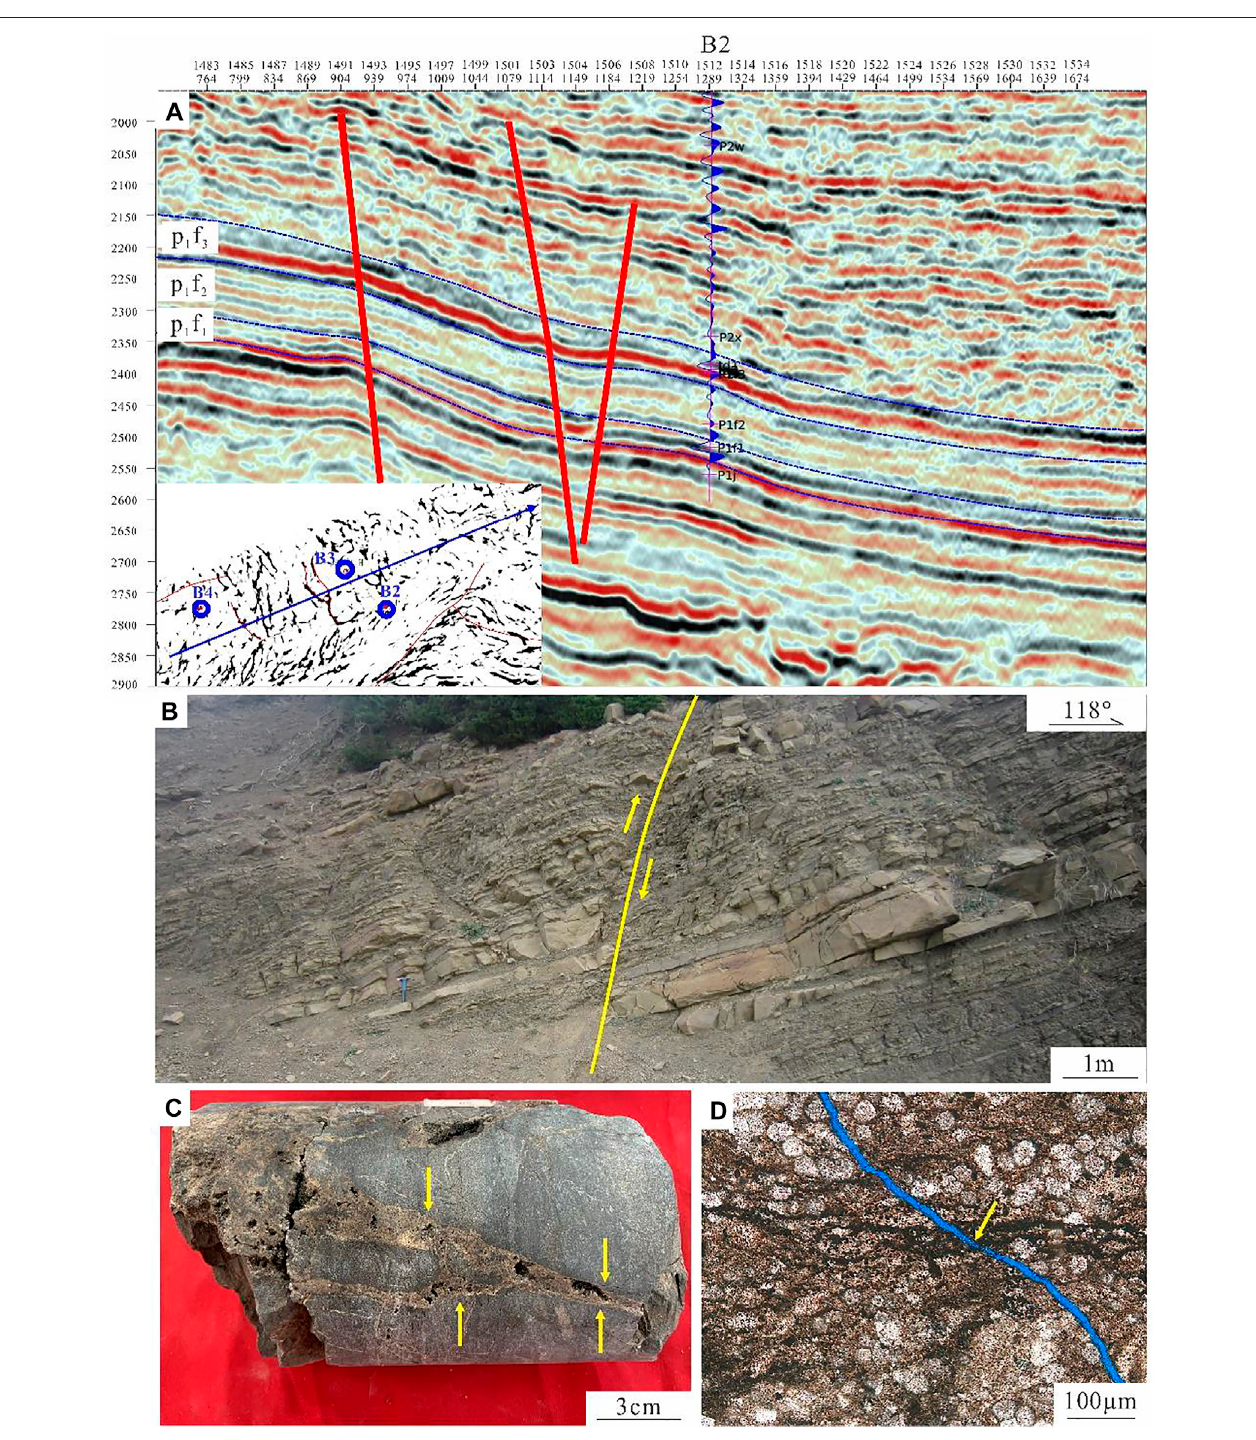
FIGURE 3| Schematic diagram of multi-scale fracture division. (A) Large-scale fractures, near NE-SW trending seismic pro fi le inthe study area. (B) Medium-scale fractures, Modi fi ed from Figure 15a in (Liu et al., 2020b). (C) Small-scale fractures, Well B3. (D) Micro-scale fractures, Well B2, buried depth 4598.61 m.